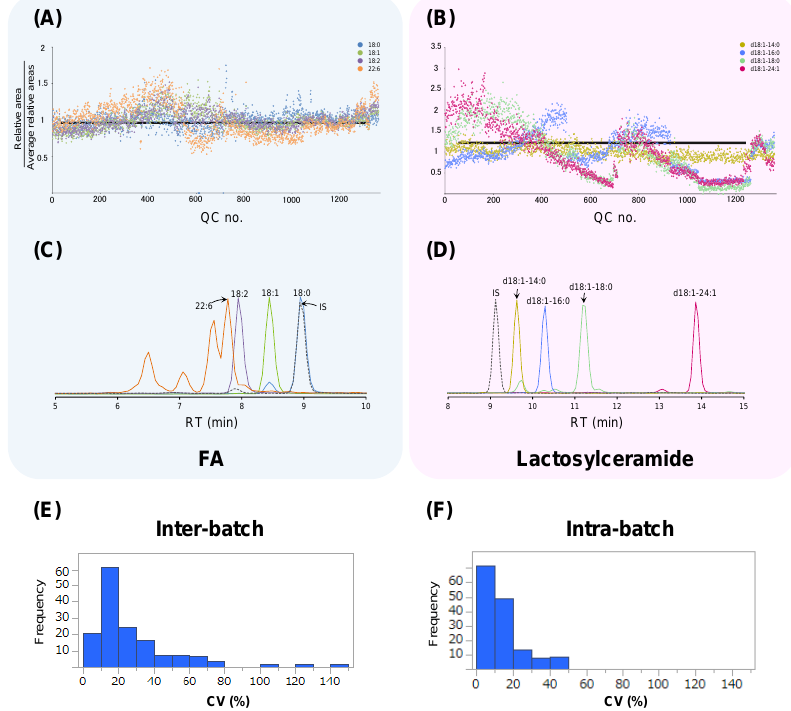
Figure 3. Fluctuation of the relative peak areas in the QC samples from multiple batches. ( A , C ) The FA data. ( B , D ) The lactosylceramide data. ( A , B ) Fluctuation of the relative peak area; that is, the peak area divided by the corresponding IS peak area. The X-axis indicates the QC sample number. ( C , D ) Representative chromatograms. ( E ) Histogram of the interbatch data. ( F ) Histogram of the intrabatch data. ( E , F ) The X- and Y-axes indicate the CV values and frequencies, respectively, of 147 metabolites.